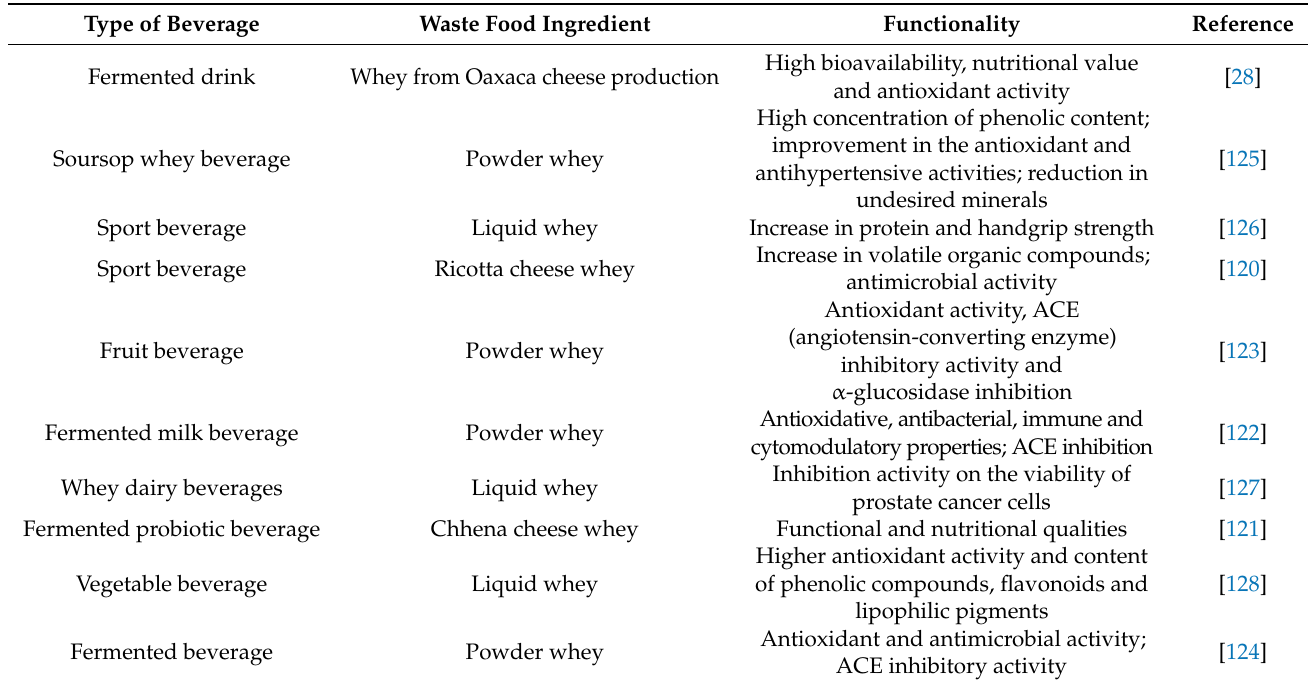
Table 3. Functional beverage processing from dairy